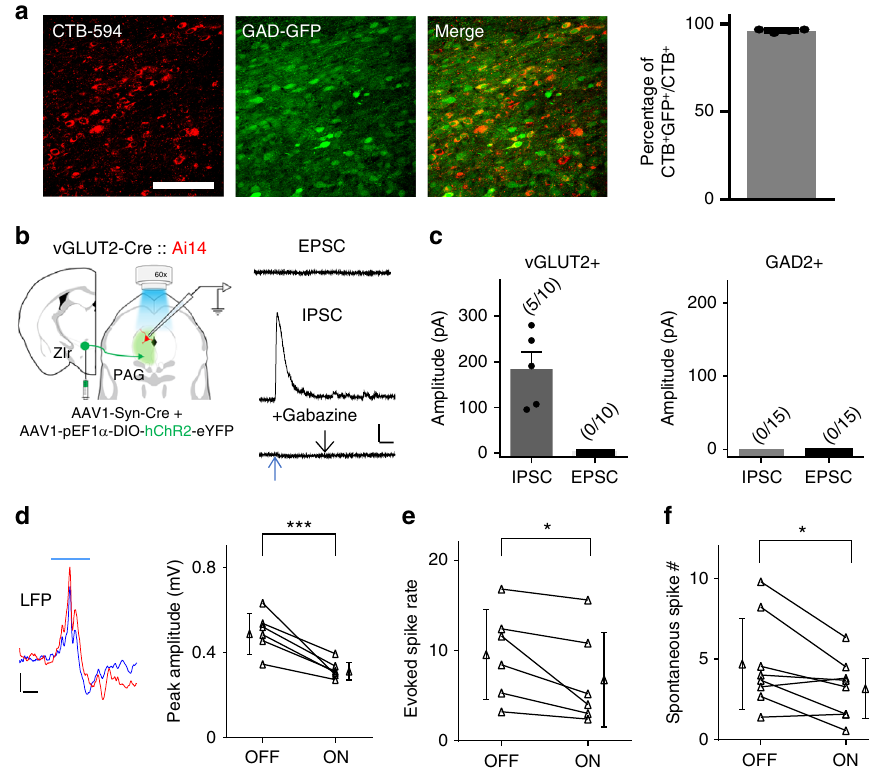
Fig. 7 GABAergic output of ZIr suppresses PAG activity. a Left three panels, co-localization of GFP (green) with CTB (red) retrogradely transported from PAG in the ZIr of a GAD67-GFP mouse. Scale: 200 µ m. Right panel, percentage of GAD-GFP + neurons in total CTB labeled neurons in ZIr. b Left, slice recording paradigm. Excitatory neurons are labeled by red color in vGLTU2-Cre::Ai14 mice. Right, average EPSC (recorded at − 70 mV) and IPSC (recorded at 0 mV) traces of a vGLUT2 + neuron in PAG. The IPSC was blocked by Gabazine (bottom). Blue arrow points to the onset of LED. Scale: 50 pA, 50 ms. c Average amplitudes of LED-evoked IPSCs and EPSCs in excitatory (left) and inhibitory (right) PAG neuron populations. d Left, average local fi eld potential recorded in PAG in response to noise without (red) and with (blue) LED stimulation in a ZIr ChR2 expressing mouse. Right, summary of peak amplitude of LFP recorded in PAG without (OFF) and with (ON) activation of ZIr. *** p = 0.004, two-sided paired t -test, n = 6 sites from two animals. e Summary of noise-evoked spike rate in PAG without and with ZIr activation. * p = 0.028, two-sided Wilcoxon signed-rank test, n = 6 sites from two animals. f Summary of spontaneous fi ring rate in PAG without and with ZIr activation. * p = 0.03, two-sided paired t -test, n = 8 sites from two animals. Solid symbol represents mean ± s.d. for d , e , f , and mean ± s.e.m. for a ,